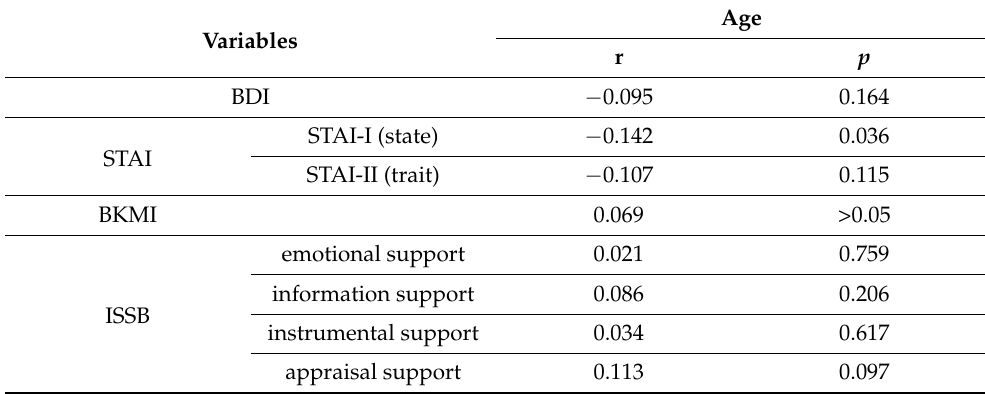
Table 3. The anxiety (state and trait) of the respondents depending on socio demographic variables.